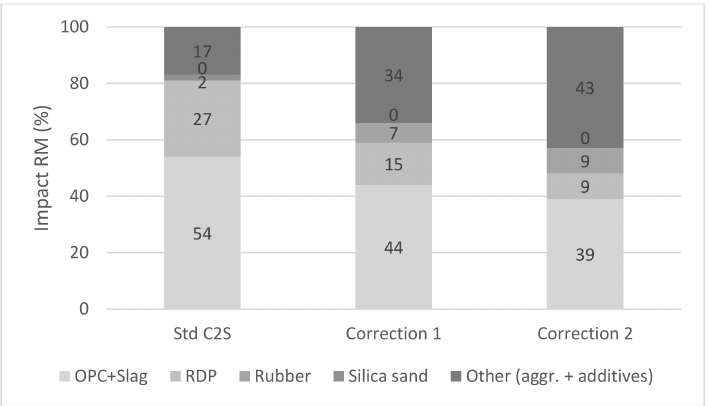
Figure 7. Impact of different components on CO 2 emissions (kg CO 2 /kg adhesive) for three tile adhesive (standard version and corrected versions with rubber